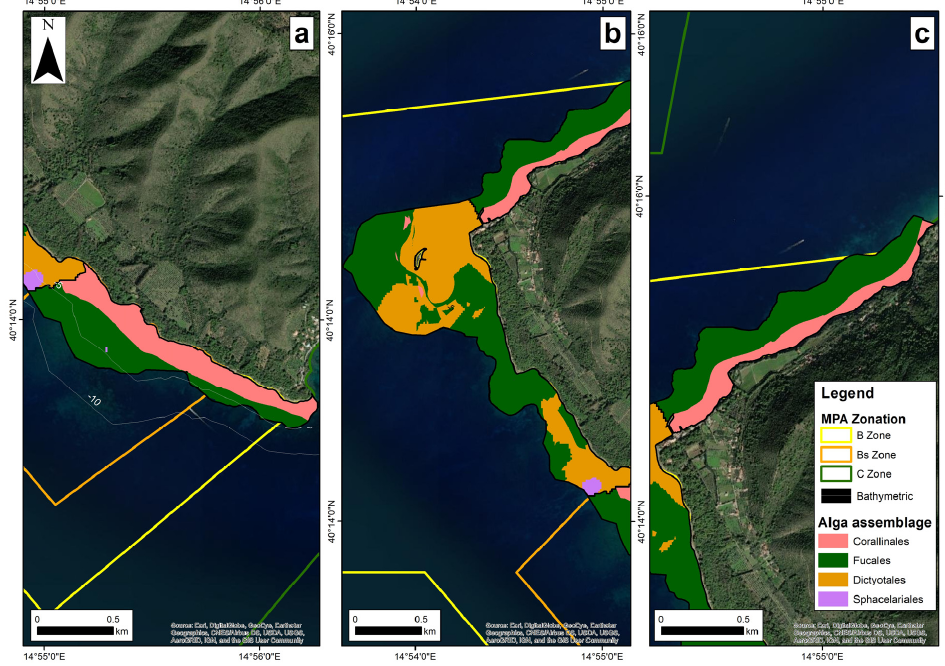
Figure 3. Distribution of the main algal assemblages resulting from the EBK model at the three sites of the Santa Maria di Castellabate MPA: ( a ) Ogliastro; ( b ) Licosa; ( c )